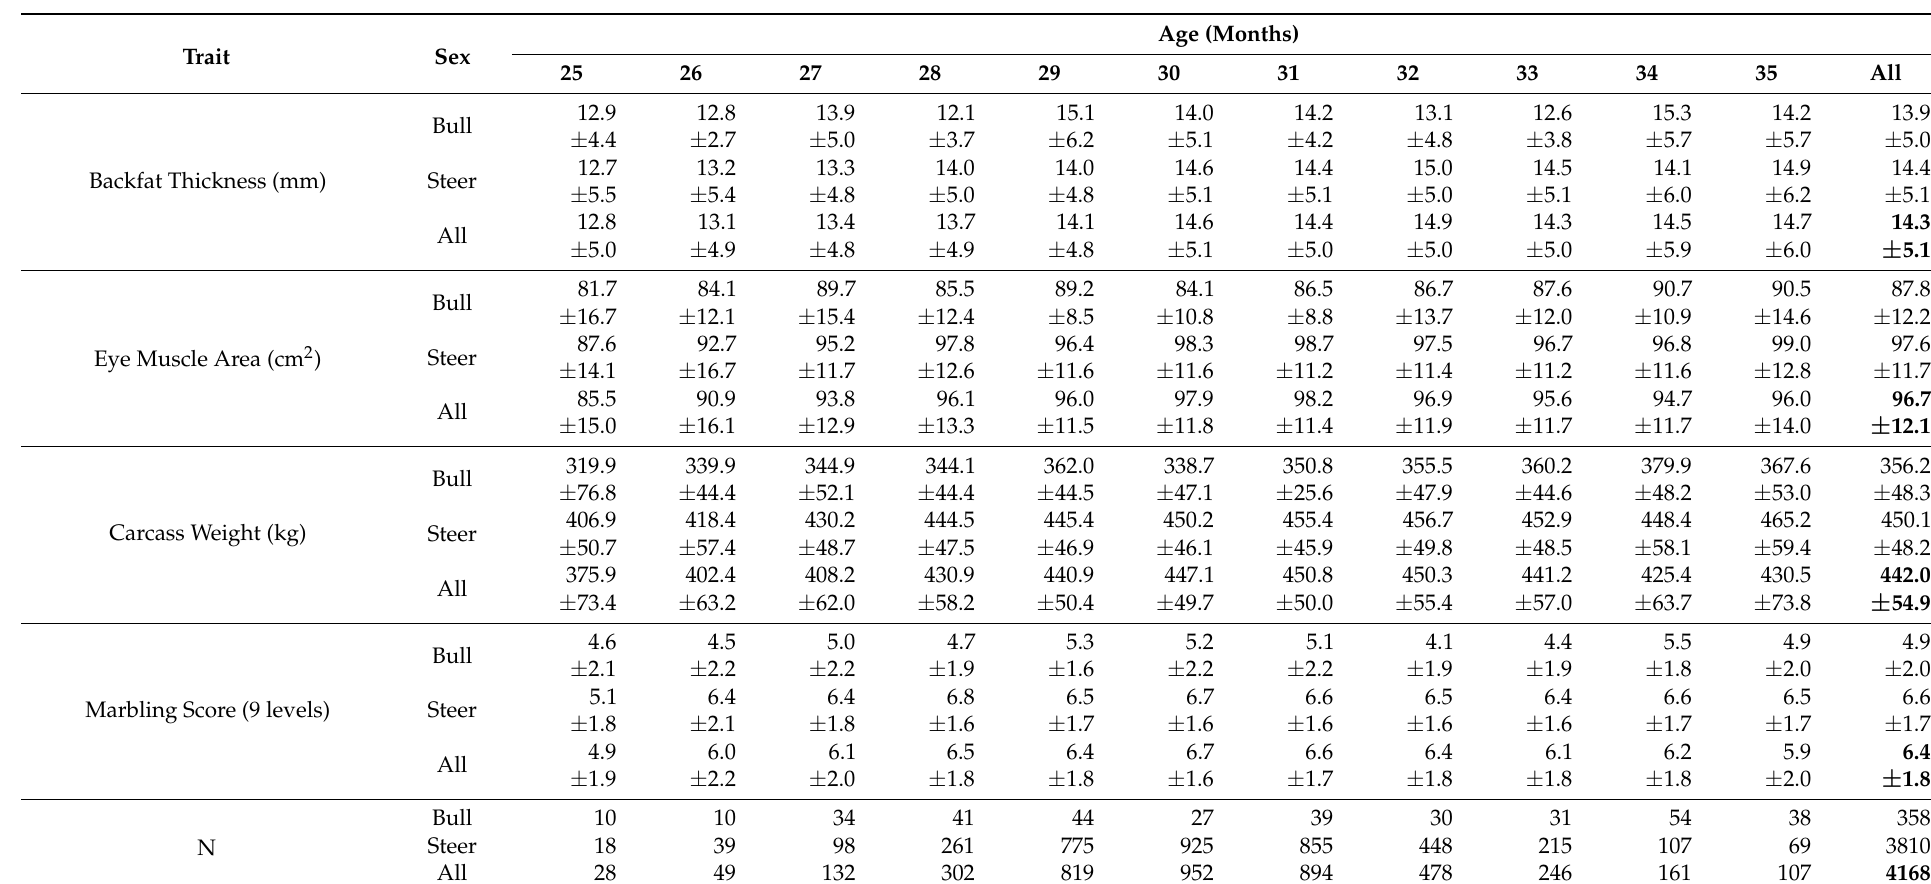
Table 2. Summary of traits (mean ± standard deviation) and number of animals (N), detailed by age, sex, and on all observations (in bold). Traits evaluated were recorded for all animals available for this